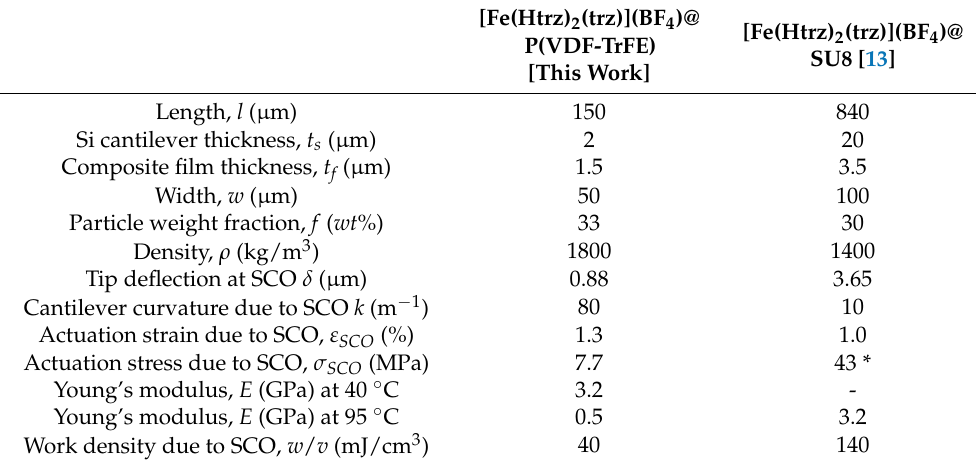
Table 1. Mechanical and actuation properties of [Fe(Htrz) 2 (trz)](BF 4 )@polymer composite